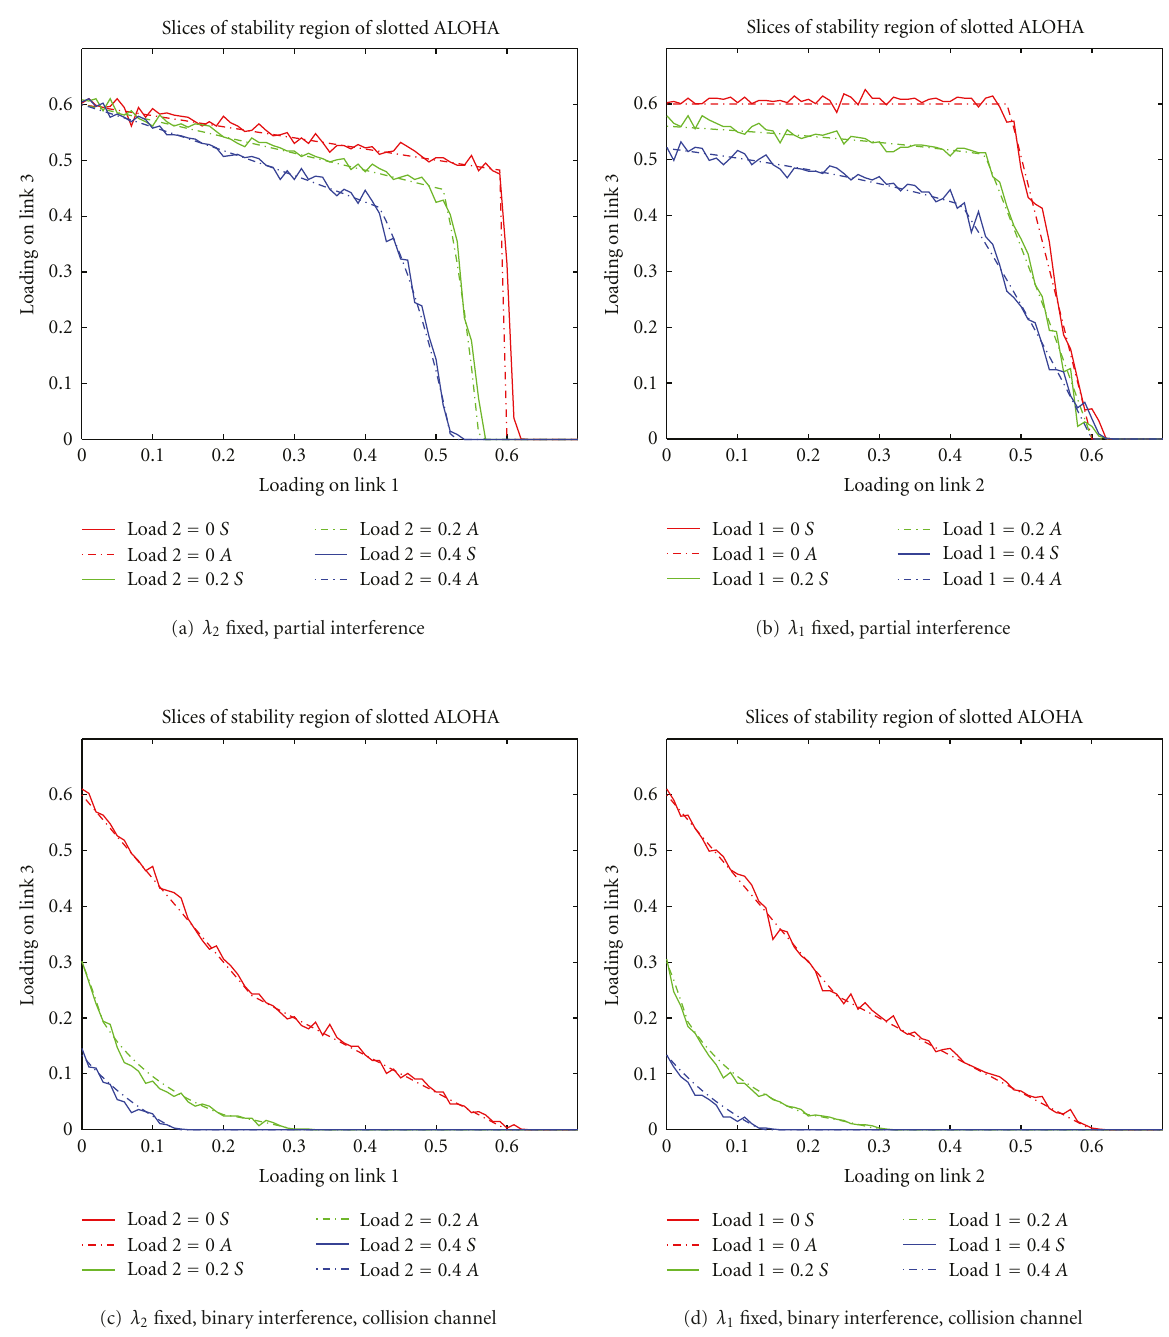
Figure 14: Cross-section of stability region of the slotted ALOHA system with M = 3 and transmission probability 0.6 under partial interference and binary interference (i.e., collision channel)